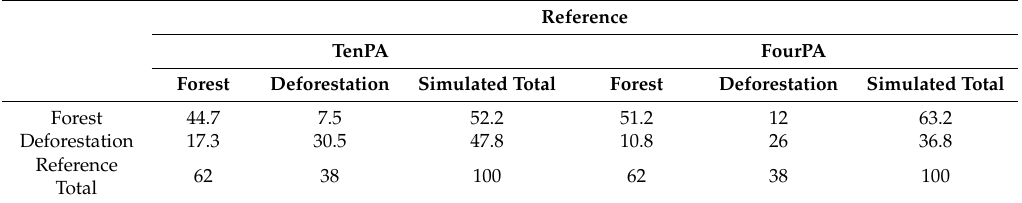
Table 4. Performance of the model in assessing the risk of future deforestation using a set of 10 predictors and using four out of 10 Table 3. Error matrix obtained by the three ‐ map comparison for FourPA and TenPA. Values are expressed in percentages.